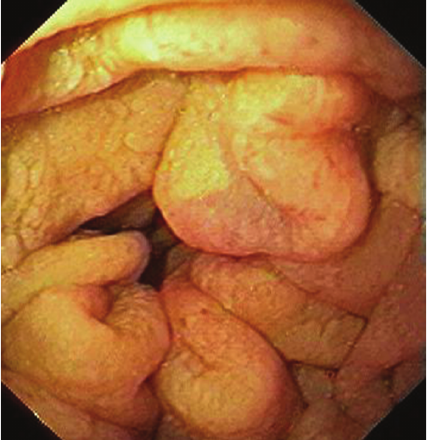
Figure 8: Whipple’s disease: jejunal mucosa is grey-pink with small whitish areas.